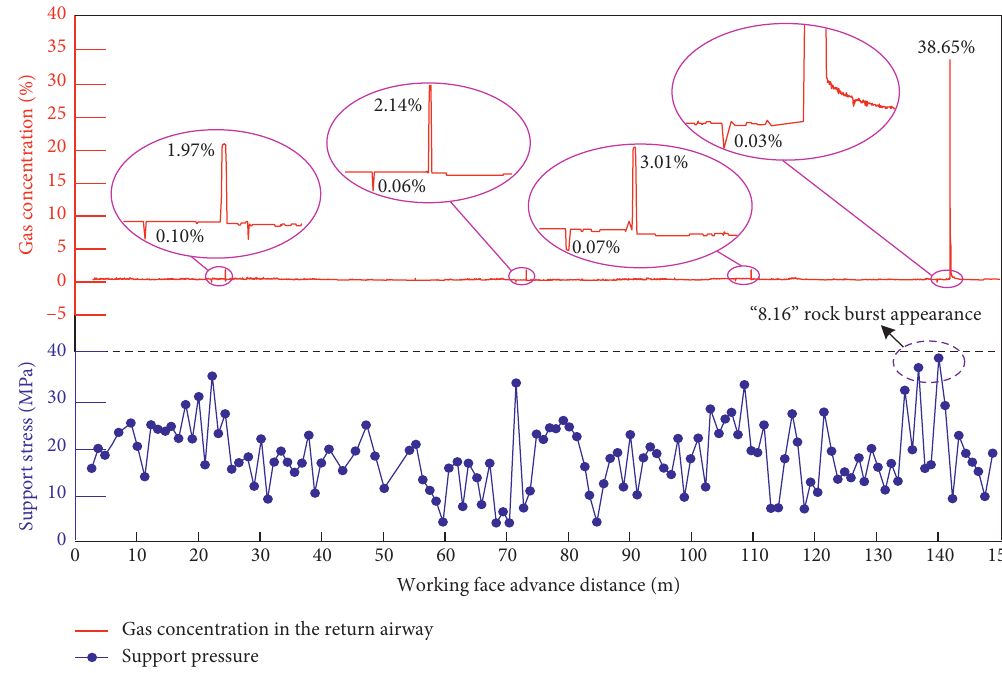
Figure 7: Variation curves of support pressure and average gas concentration with the advancement distance of the working face.